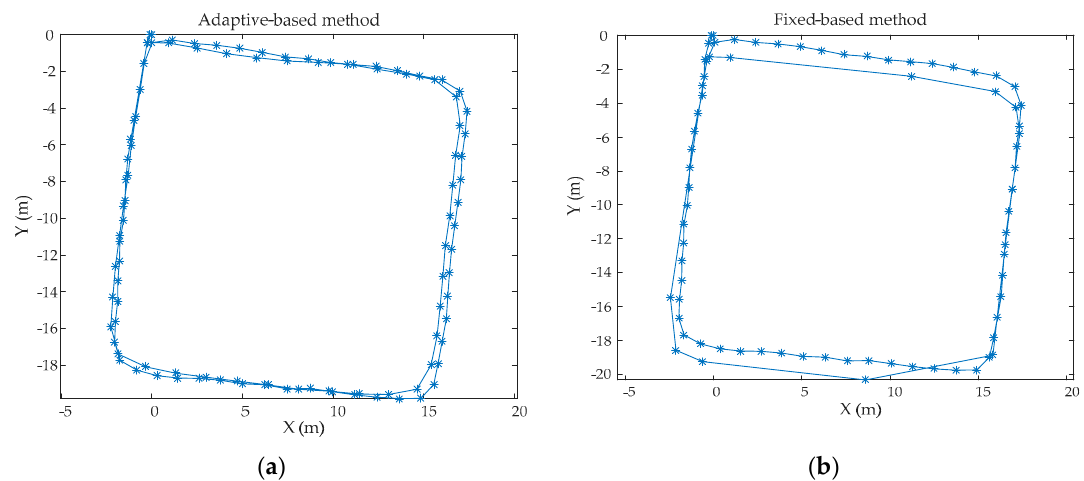
Figure 9. The trajectories of Person A: ( a ) the trajectories using the adaptive zero-velocity detection algorithm; ( b ) the trajectories using the fixed threshold-based algorithm.